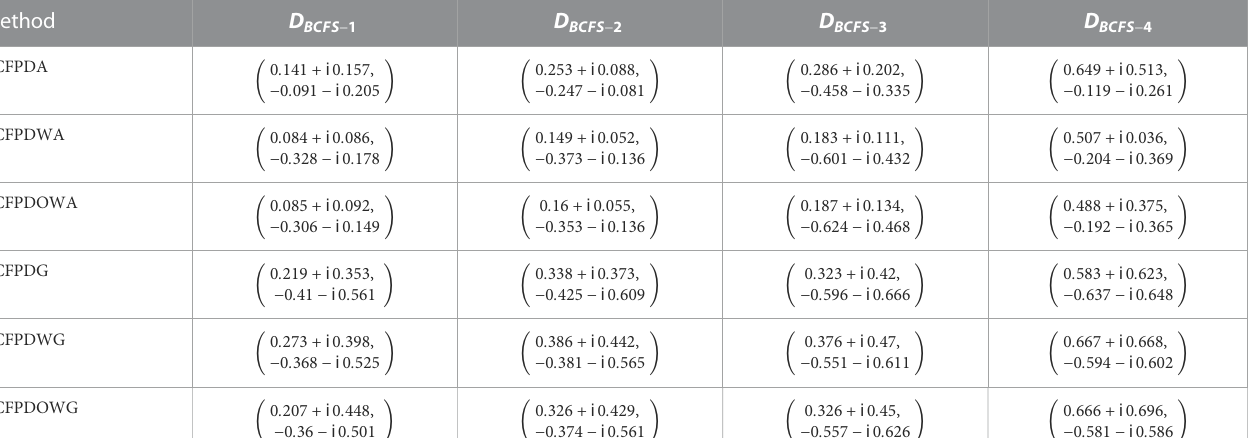
TABLE 4 Aggregated outcomes.